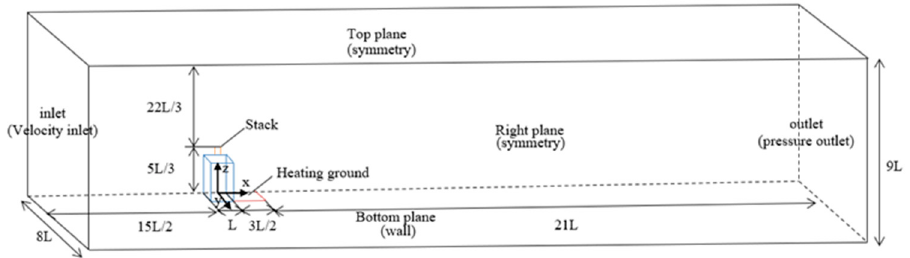
Figure 5. Computational domain and boundary conditions of the heating building case.